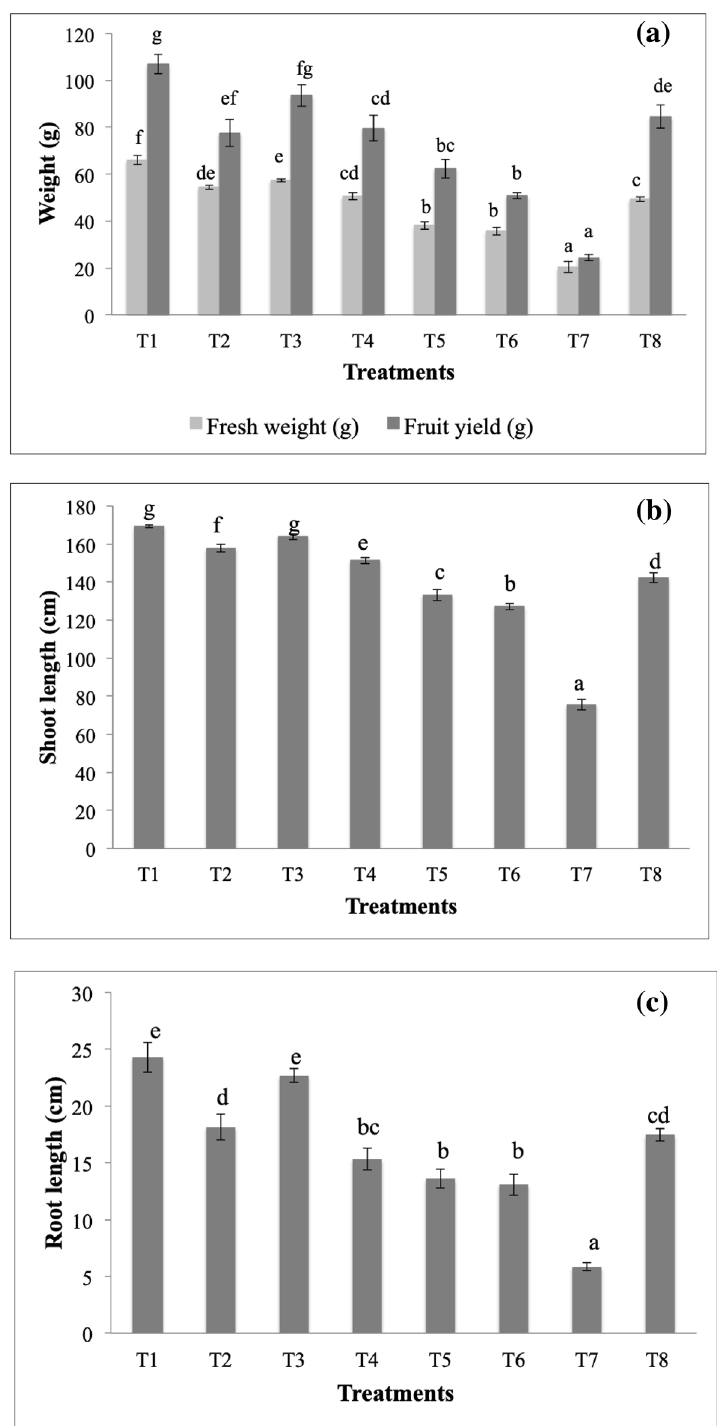
Figure 2. ( a ) Fresh weight and fruit yield, ( b ) shoot length and ( c ) root length of tomato plants treated with T1 = water dispersible granules (WDG) ( B. subtilis ) + F. oxysporum , T2 = WDG ( T. harzianum ) + F. oxysporum , T3 = Talc formulation ( B. subtilis ) + F. oxysporum , T4 = Talc formulation ( T. harzianum ) + F. oxysporum , T5 = alginate beads ( B. subtilis ) + F. oxysporum , T6 = alginate beads ( T. harzianum ) + F. oxysporum , T7 = only F. oxysporum and T8 = carbendazim (1000 ppm) + F. oxysporum . In each figure, bars with significantly different values by Tukey’s HSD test ( p < 0.05) are marked with different letters. Error bars indicate standard deviation of